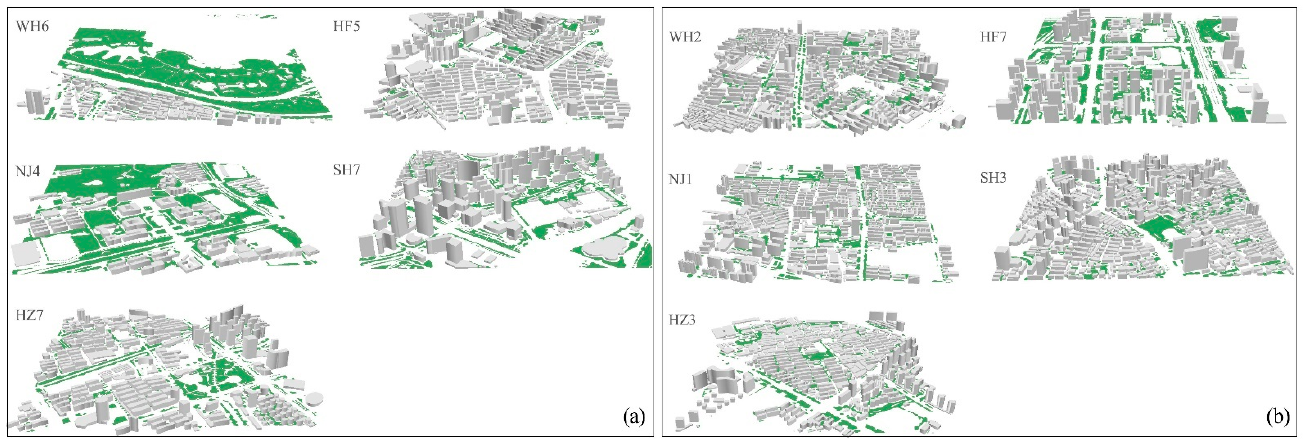
Figure 6. Neighborhoods with ( a ) strong and ( b ) weak PM 2.5 reduction capacity.